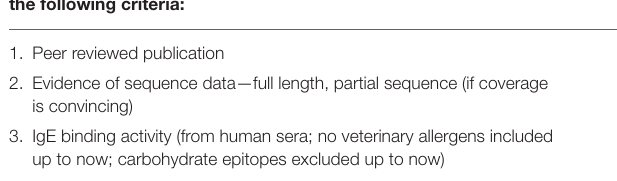
TABLE 3 | COMPARE database criteria for an allergen sequence. Allergens are included in COMPARE when they meet all three of the following